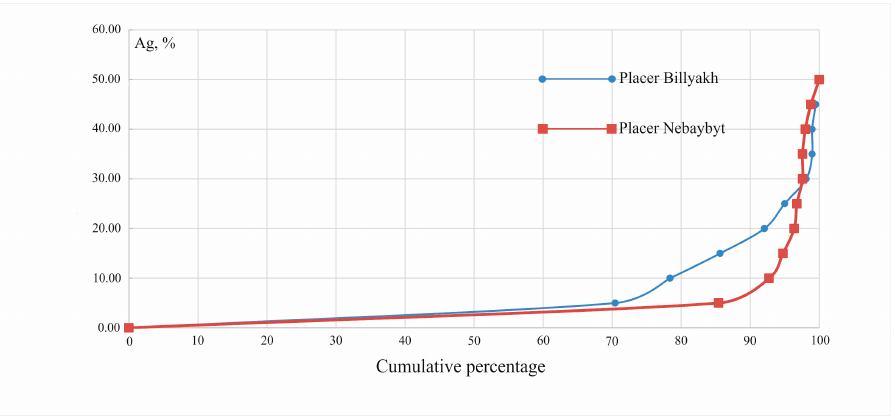
Figure 10. Cumulative Ag content chart. According to the data of 578 (Billyakh placer) and 247 (Nebaibyt placer) determinations of the chemical composition of gold.